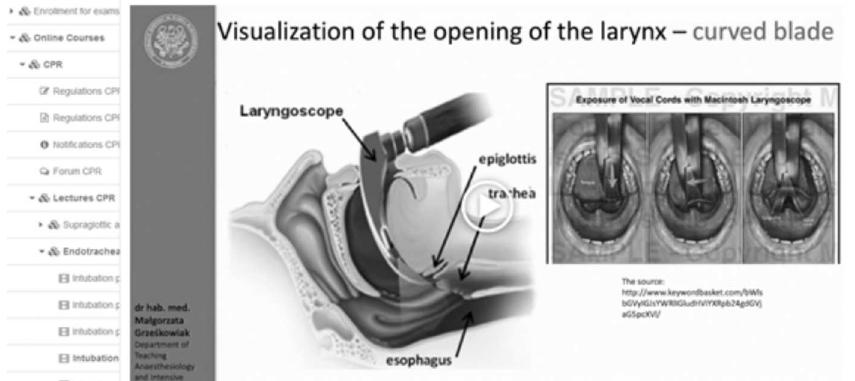
Figure 9. The use of pictures/figures in an e-learning presentation to demon- strate the technique of laryngoscopy during endotracheal